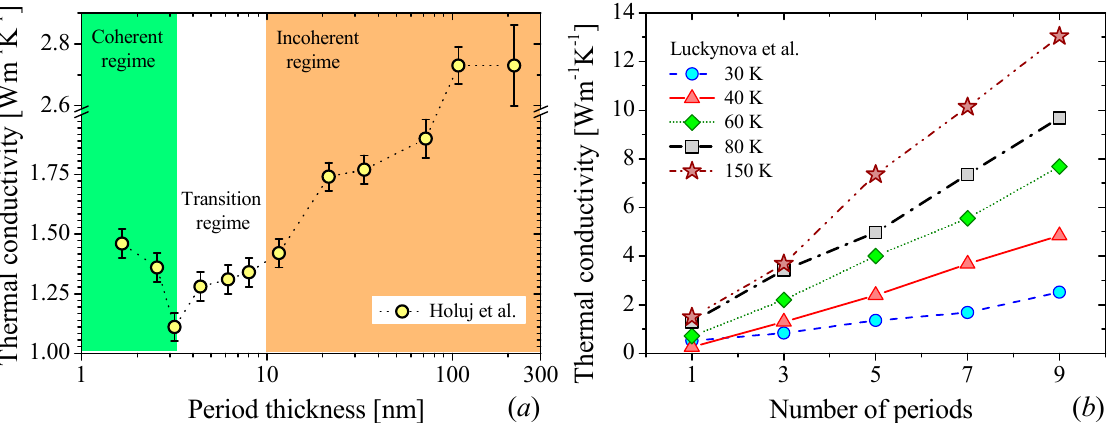
Figure 3. Phonon engineering in superlattices. Experimental k as a function of: ( a ) period thickness of (TiNiSn):(HfNiSn) half-Heusler superlattices, ( b ) number of periods of GaAs/AlAs superlattices. Adapted from Holuj et al. [60] and Luckynova et al., [14], respectively. ( a ) The crossover between coherent-incoherent (wave-particle) regimes is observed as a minimum in k vs. d SL , while in ( b ), the linearity of the k vs. N suggests that phonon heat conduction is coherent.